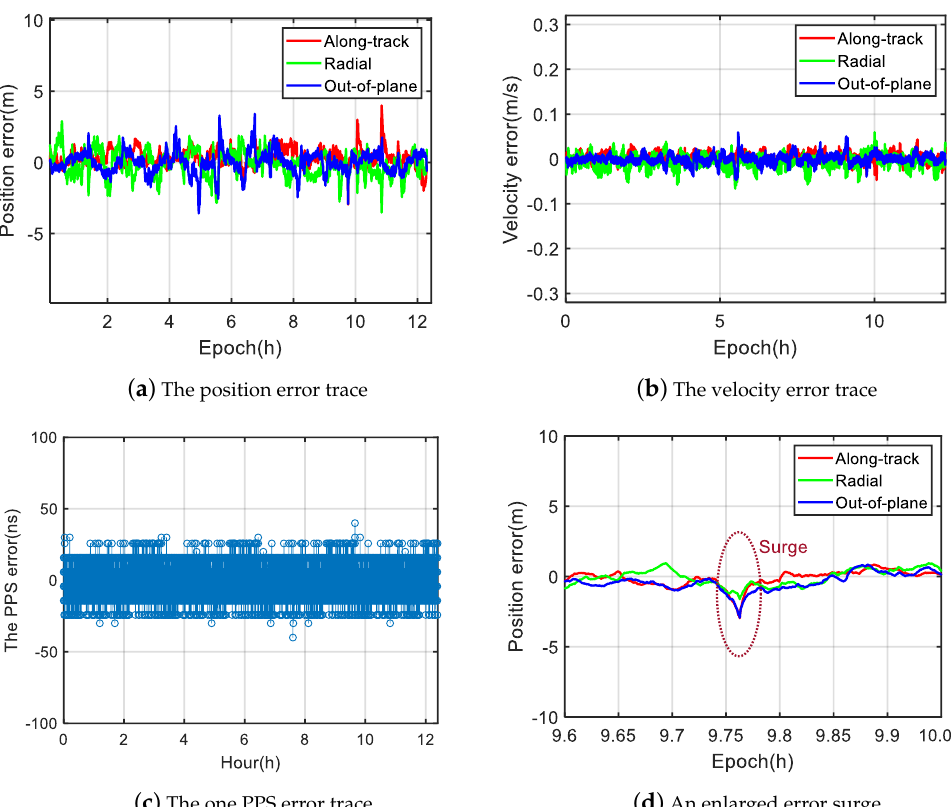
Figure 6. Performance of the proposed